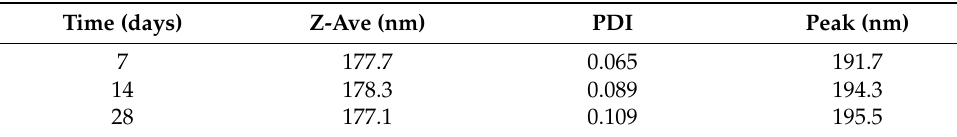
Table 1. WPUA particle size distribution